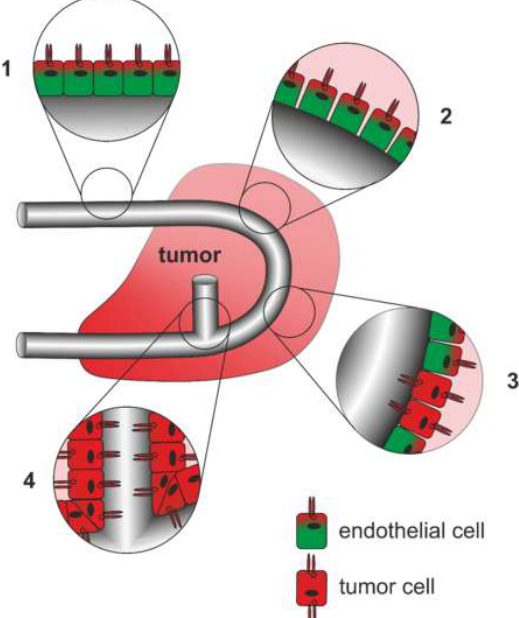
Figure 5. Accessibility of neuropilin-1 in different types of tumor vessels. ( 1 ) In normal endothelium, NRP1 (highlighted in red), located on the basolateral side of ECs (green), is inaccessible from the bloodstream. ( 2 ) In tumors, the endothelium is generally leaky. Therefore, when viewed from the bloodstream, NRP1 is no longer inaccessible on the basolateral side. ( 3 ) In composite vessels of the tumor vasculature, patches of ECs are replaced by tumor cells that have acquired an EC-like phenotype. They have NRP1 on their entire surface, making NRP1 easily accessible. ( 4 ) When vasculogenic mimicry occurs, tubes formed by tumor cells are directly connected to the bloodstream. At such sites, NRP1 is particularly accessible from the bloodstream.